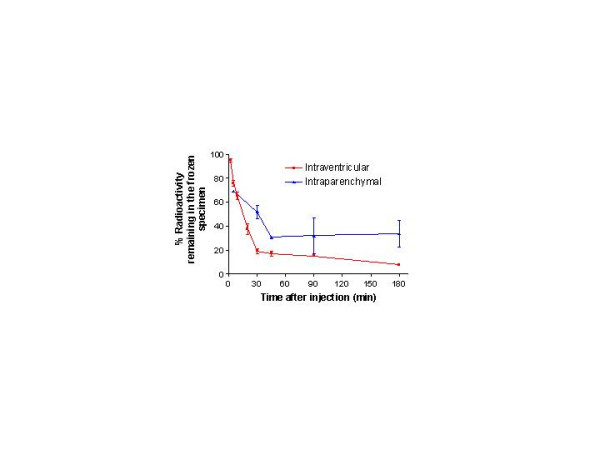
The percentage of radioactivity remaining in the entire system of frozen brain, blood, CSF, and meninges over time following either intraventricular or intraparenchymal infusion of 125I-IGF-1. There were 4–5 experiments per mean and time for the intraventricular infusions but only 2–3 for the intraparenchymal ones, which were accidental and not intended. Data are shown as mean ± SD. The initial phase dominated the first 30 min of clearance and accounted for most of the loss from the system for both sets of infusion data. From 45 min onward, virtually no radioactivity was lost from the system with the intraparenchymal infusion, whereas 125I-activity declined very slowly with intraventricular infusion (40% decline from 45 to 180 min).